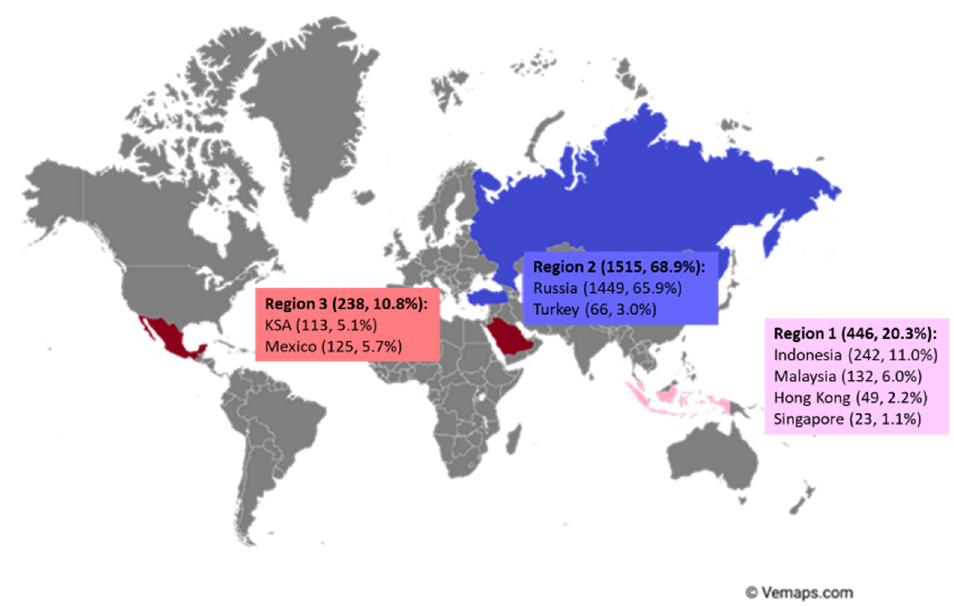
Figure 1. The distribution of survey respondents (number of respondents, % of total respondents). Pediatricians represented the highest percentage of respondents (80.3%, 1759/2191), followed by pediatric gastroenterologists (7%, 154/2191), GP (6.3%, 139/2191) and